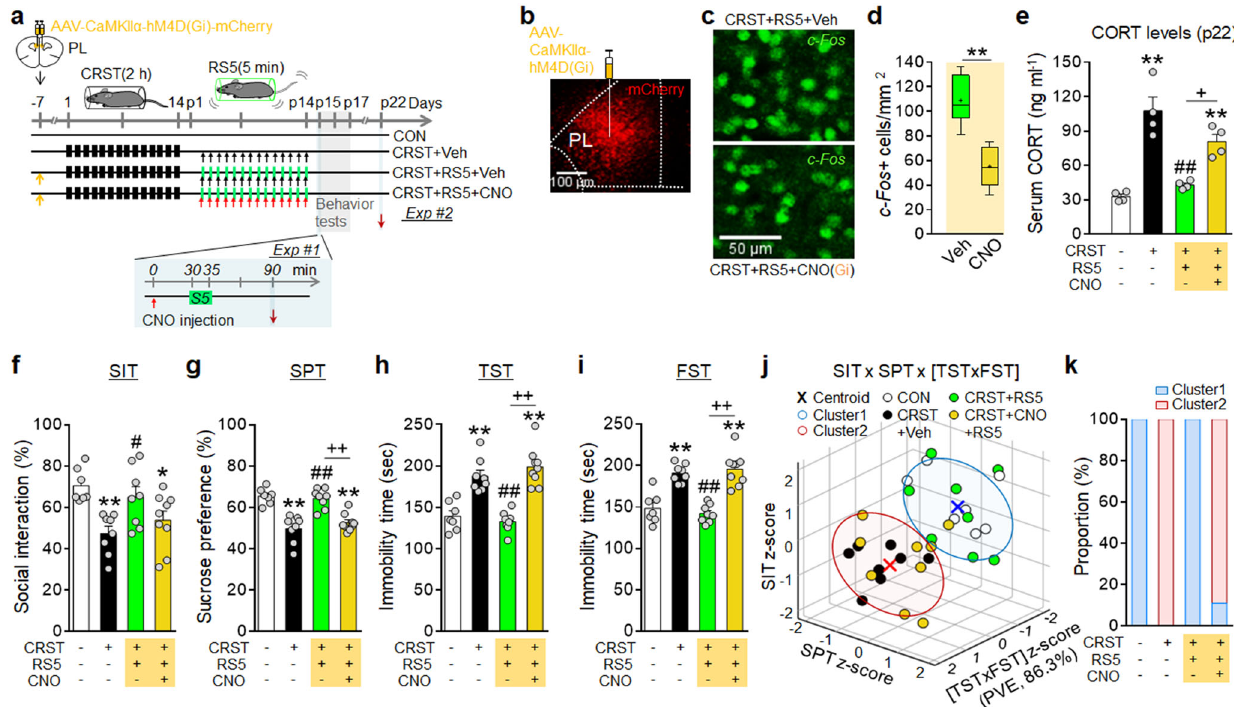
Fig. 8 Chemogenetic inhibition of PL neurons blocks the anti-depressive effects of RS5. a Experimental design. AAV8-CaMKII α -hM4D(Gi)-mCherry inhibitory vector was injected into the PL. Mice were then subjected to CRST, followed by RS5 treatment with Veh or CNO injection. CNO, 3 mg kg − 1 per injection (i.p.). Red arrows ( ↓ ) in Exp #1, sample prep point and red arrow ( ↓ ) on post-stress day 22, serum collection point. b – e Photomicrograph showing mCherry expression by the injected vector in the PL ( b ). RS5-induced c-Fos expression levels in the PL after CNO or Veh injection (Exp #1) ( c , d ) ( n = 4 – 6 per group). Basal serum CORT levels in the indicated groups on post-stress day 22 (Exp #2) ( e ) ( n = 7 – 8 animals per group). f – k The % time of social interaction in the SIT ( f ), the % sucrose-preference in the SPT ( g ), and immobility time in the TST ( h ), and FST ( i ) for the indicated groups (Exp #2). K - means clustering of individuals in the SIT × SPT × [TST × FST] matrix ( j ) and % composition of each group in the clusters ( k ) ( n = 7 – 9 animals per group). Data were mean ± SEM. Gray circles represent individual data points. *, the difference compared to control; #, the difference compared to CRST. *, #, p < 0.05, **, ##, p < 0.01 (Two-sided Student ’ s t -test; one-way ANOVA followed by Newman – Keuls post hoc test). See Supplementary Data 4 for statistical